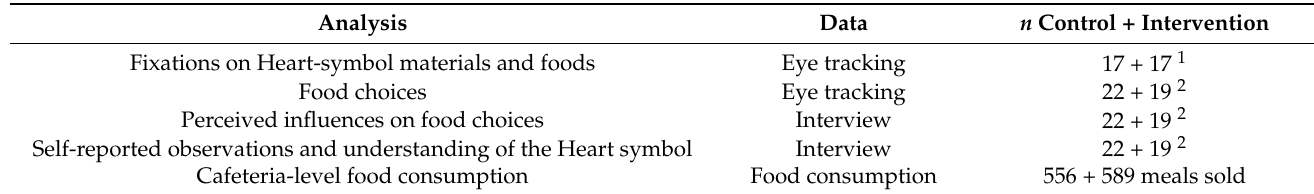
Table 1. The number of observations included in each analysis conducted in the